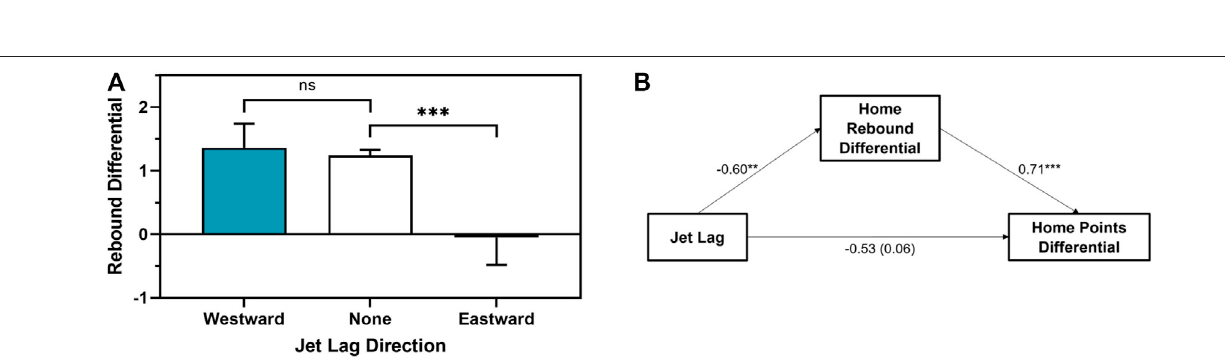
FIGURE 3 | Raw means based on the association between (A) the magnitude of eastward jet lag (white = none, yellow = 1h (reference), orange = 2h) and home teampointsdifferential,and (B) eastwardtravelandjetlagcombinations(white=notravel,grey=eastwardtravelandnojetlag,orange,eastwardjetlag)andhometeam points differential. ns = not signi fi cant, p > 0.10, † p < 0.07, * p < 0.05.